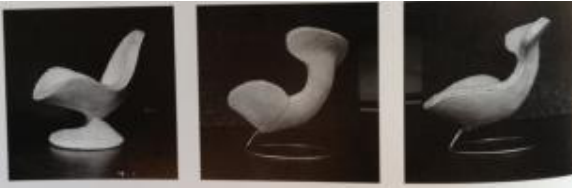
Fig. 1. The experimental